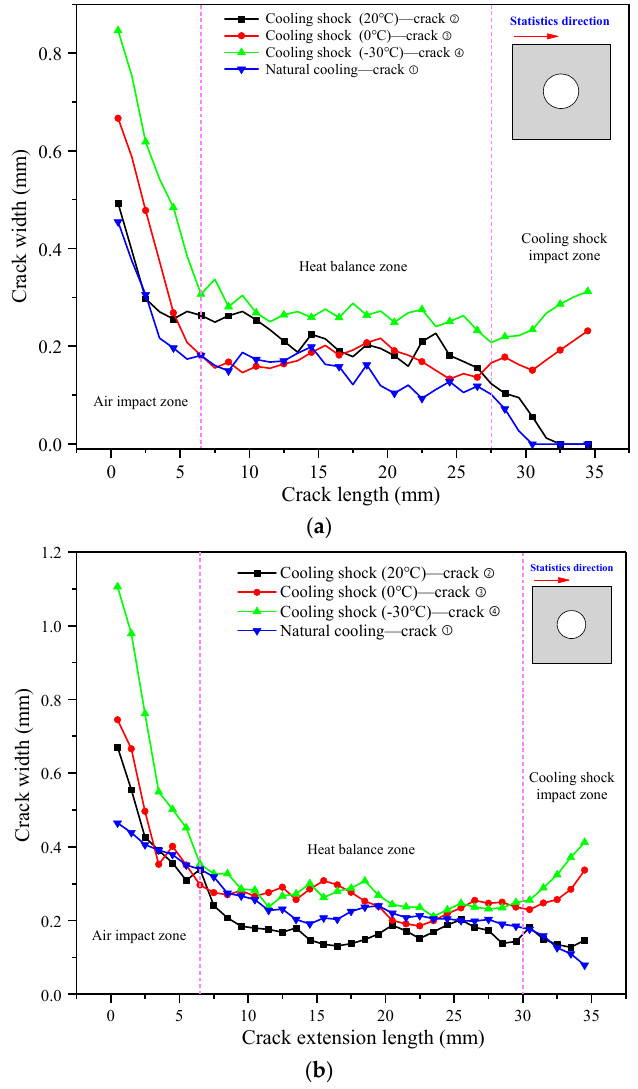
Figure 6. Measured results of crack widths along the section direction due to different cooling shocks: ( a ) measured results of crack widths (550 °C) and ( b ) measured results of crack widths (750 °C).